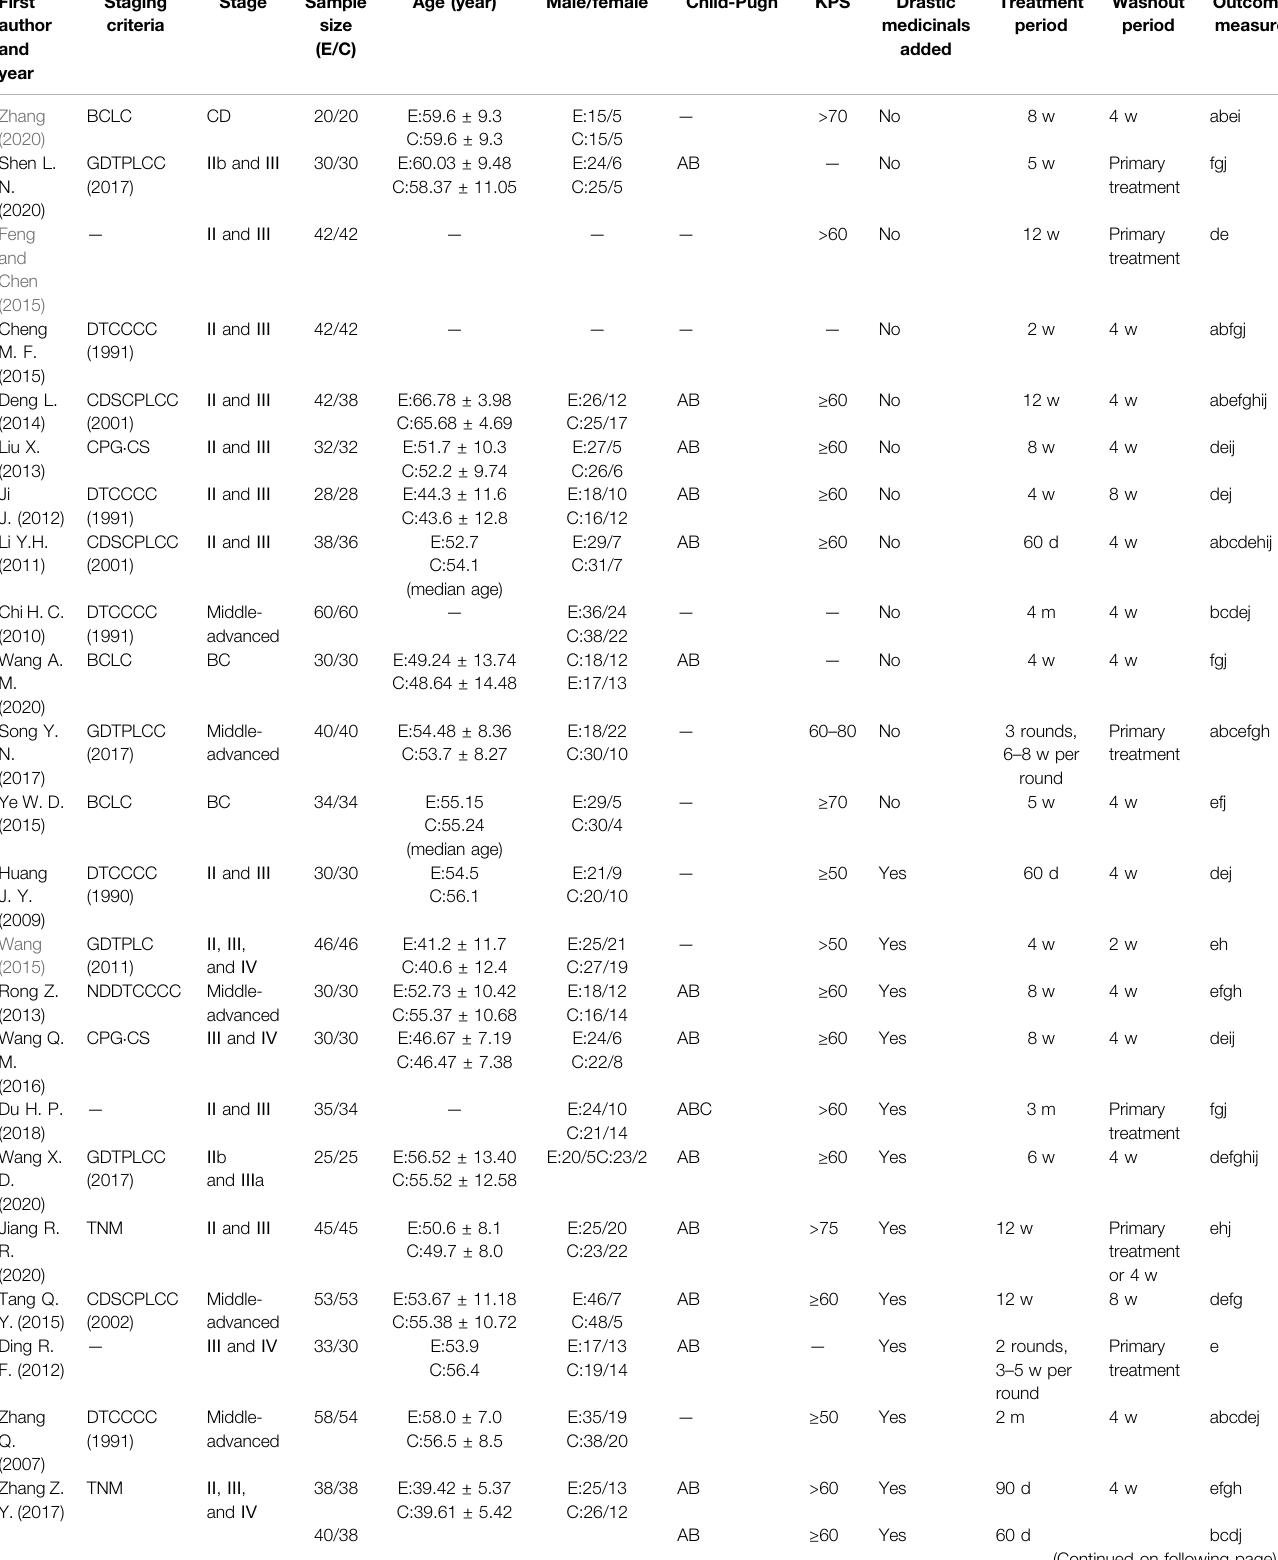
TABLE 1 | Basic characteristics of the included